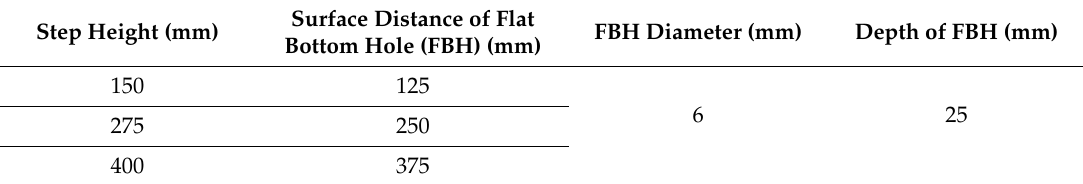
Table 2. The dimensions of the step-type flat bottom hole during the plotting of a distant amplitude correction (DAC)